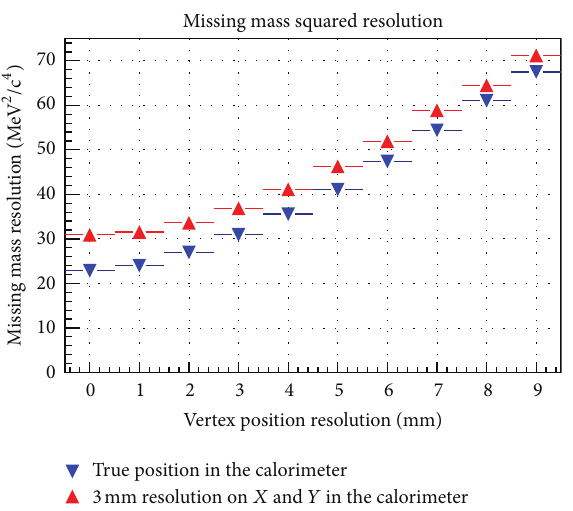
Figure 11: Schematics of the beam monitor. A design with 2mm strips both in horizontal and in vertical direction is